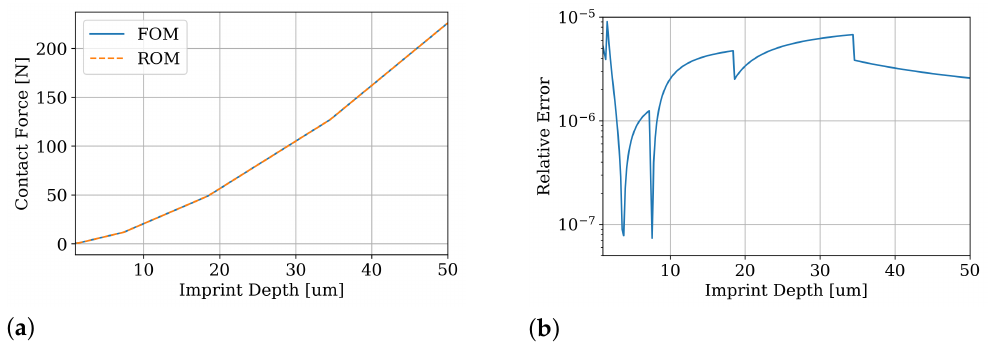
Figure 8. Static force opposing the sphere’s displacement into the kick-actuator. The sphere starts just in contact with the actuator’s top surface and is displaced 50µm into the surface in increments of − 0.2µm. ( a ) Solutions of the reference FEM model and the ROM. Note that the force is one quarter of the full contact force. ( b ) The ROM’s relative error, demonstrating its